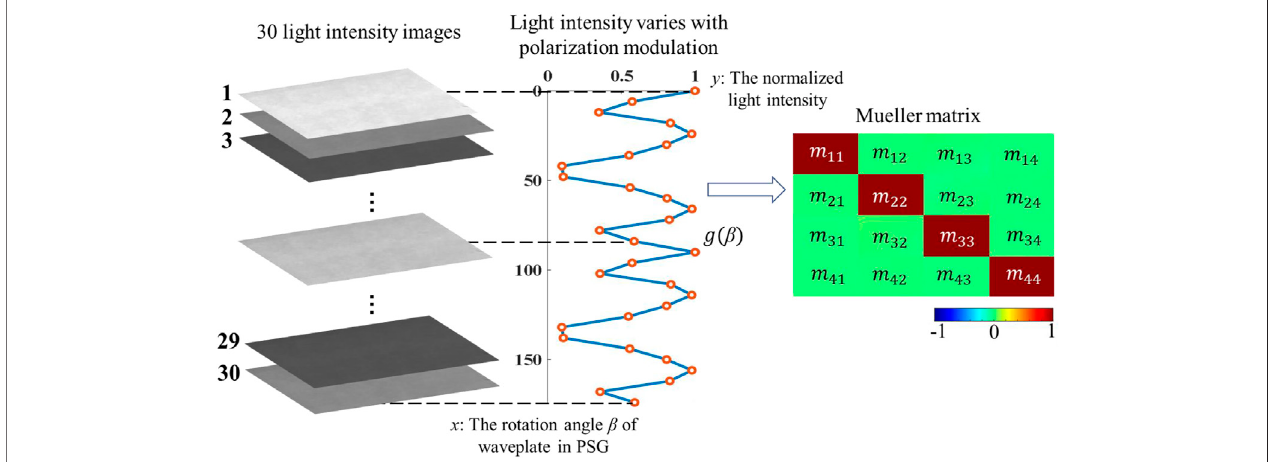
FIGURE 3 | Schematic diagram of the periodically varying light intensity modulated by the polarizing